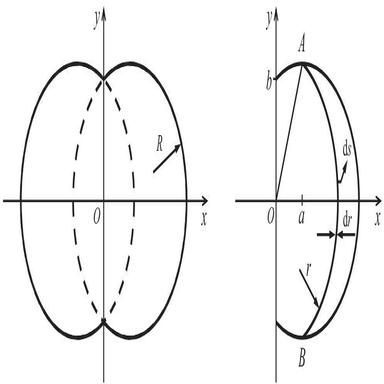
Schematic model of the proposed intersecting circular cross-section of helical fiber tows.